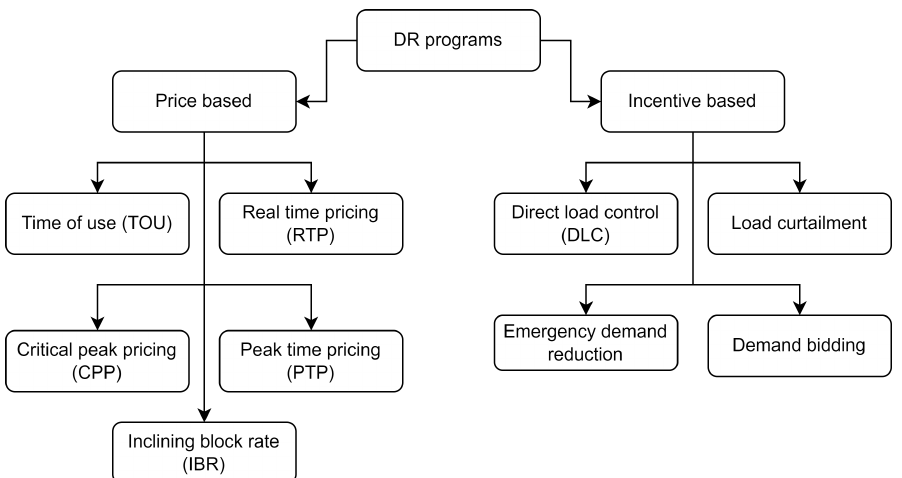
Figure 9. Overview and division of demand response